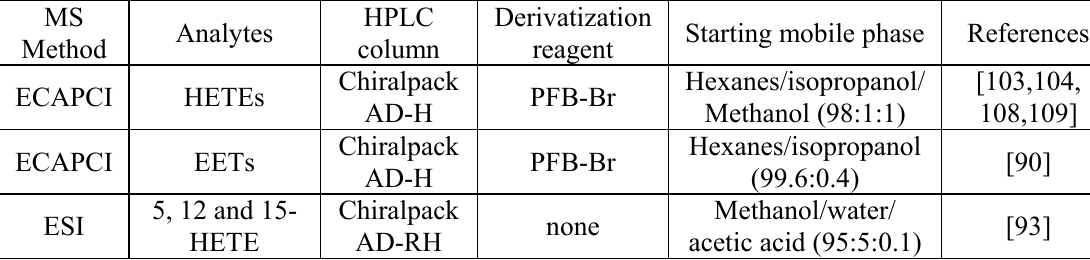
Table 1 . Chiral LC-MS separation for